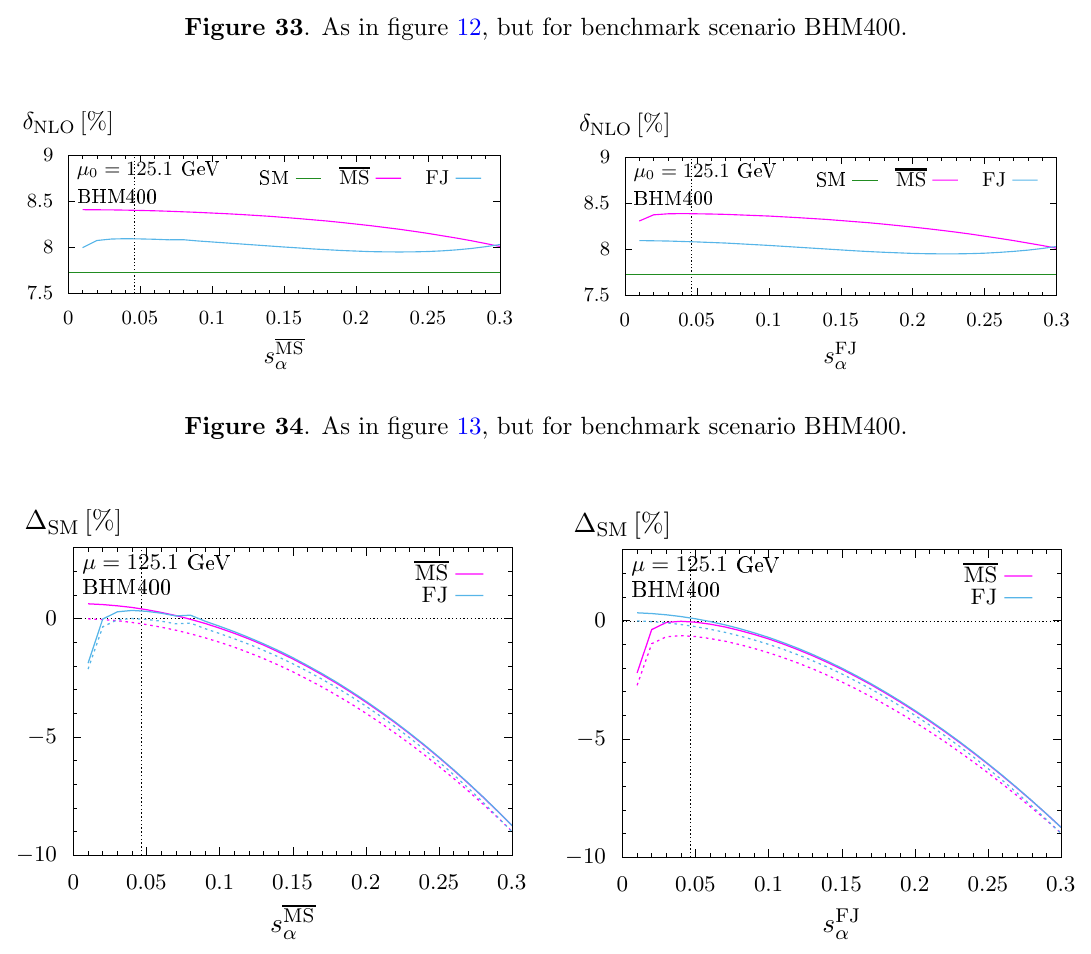
Figure 35 . As in (cid:12)gure 14, but for benchmark scenario